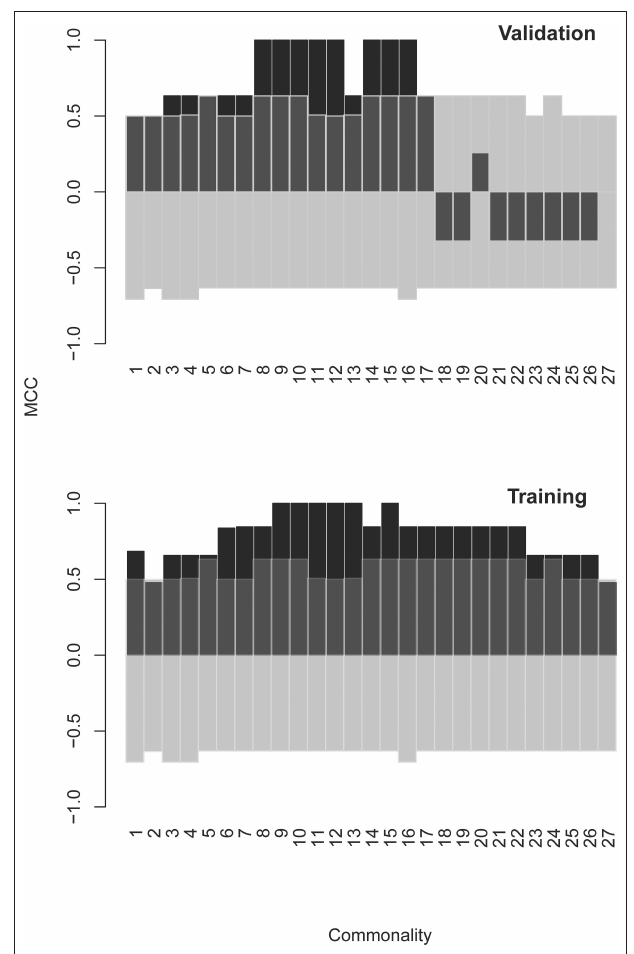
FIGURE 7 | Matthews correlation coefficient (MCC) as a measure of the quality of SVM models using different optimized feature sets. The models were constructed using GBM specific feature sets derived by a combination of filtering and backward and forward feature selection steps. Finally, consensus feature sets were formed from at least n “leave one out” groups of patients: n = 1 means all features from all groups were pooled, and n = 27 means the set contains only the three features found in all 27 groups (there was only one feature found in all 28 groups). The testing set consists of the cases in batch “R” that were omitted from the batch compensated pooled patient group. The model predicts correctly the classification of these cases. As the values in batch “R” were not subject to batch compensation, the validation also serves as a control against artifacts introduced by the ComBat function. The transparent bars indicate the 5% and the 95% confidence limits of MCC calculated on the basis of 1,000 scrambled matrices. SVM, support